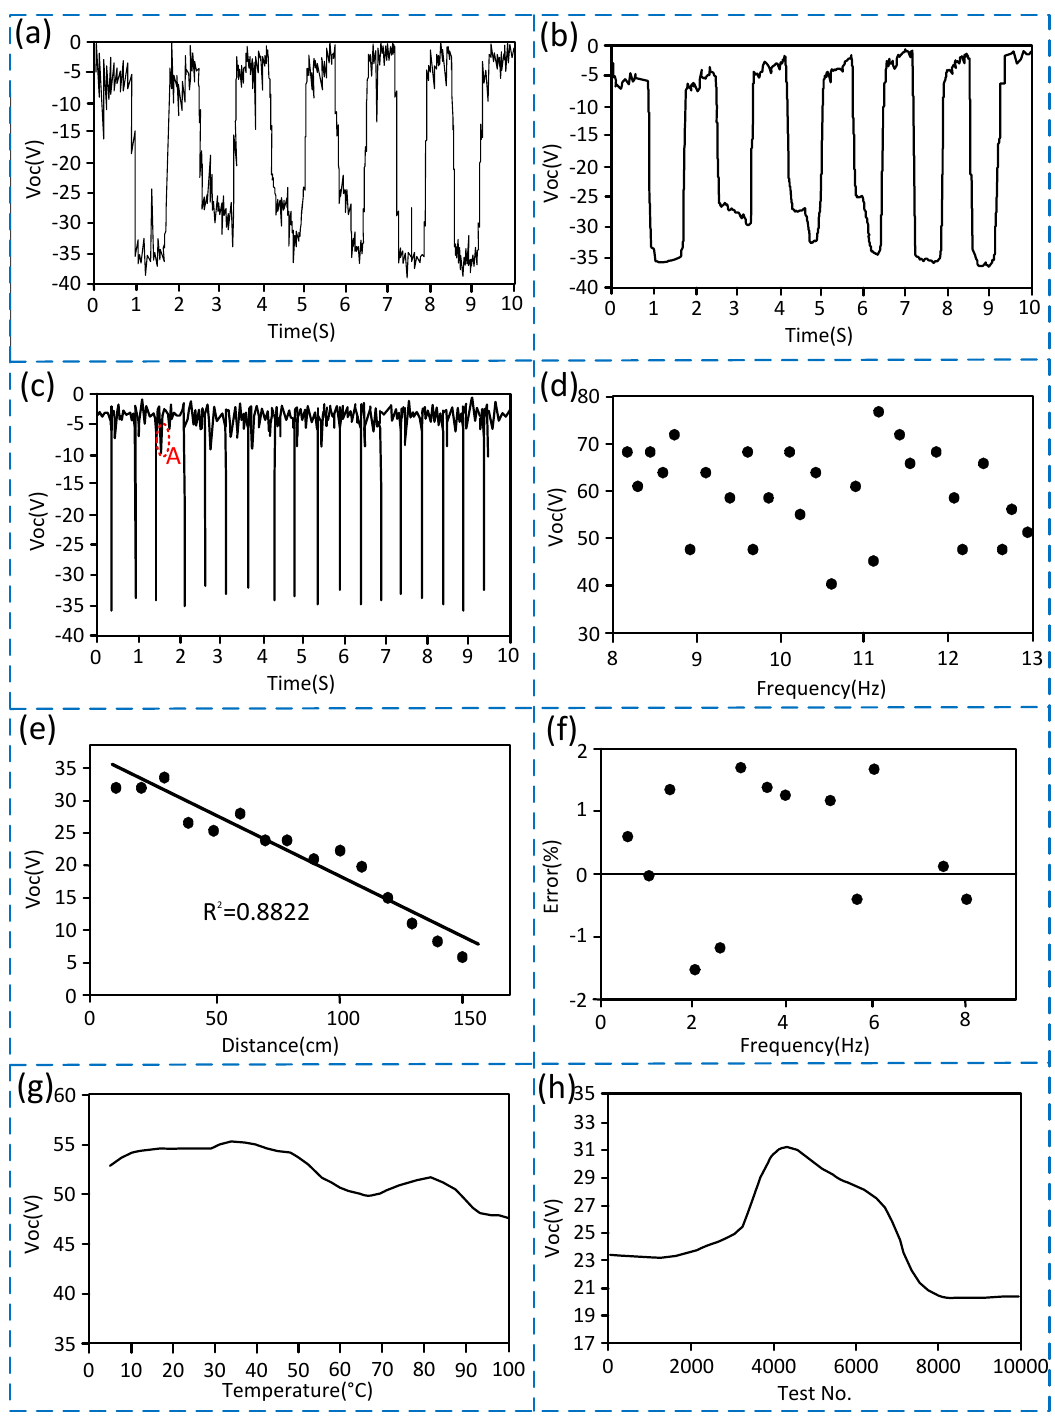
Figure 5. Test results of the S-TENG sensing performance. ( a ) Curve showing the output voltage of the S-TENG when the vibration frequency is 0.6 Hz (Unfiltered signal); ( b ) Curve showing the output voltage of the S-TENG when the vibration frequency is 0.6 Hz (Filtered Signal); ( c ) Curve showing the output voltage of the S-TENG when the vibration frequency is 1.8 Hz; ( d ) Scatter plot of output voltage of the S-TENG when vibration frequency exceeds 8 Hz; ( e ) Curve showing the variation of the output voltage over the distance from the vibration source when the vibration frequency is 2 Hz; ( f ) Measurement error scatter plot; ( g ) Curve showing the variation of the output voltage over the temperature when the vibration frequency is 4.5 Hz; ( h ) Curve showing the variation of the output voltage over the test times when the vibration frequency is 1